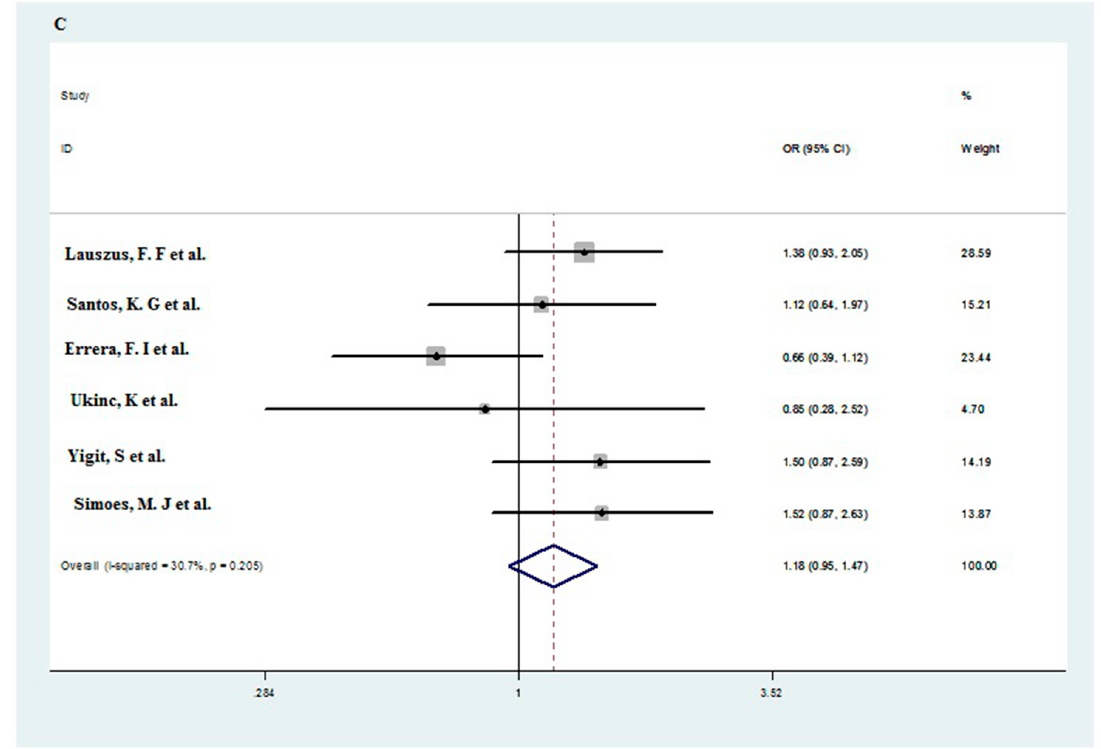
Figure 2. Oddsratios (ORs; log scale) of diabetic retinopathy (DR) associated with MTHFR 677C/T polymorphism for dominant genetic model. The graph shows individual and pooled estimates for different ethnic groups ( A for all studies; B for Asian group; C for Non-Asian group). Table 3. Summary ORs and heterogeneity results for associations between the MTHFR C677T In stratified analysis by ethnicity and DM type, we further detected that the Asian group, polymorphism and DR.